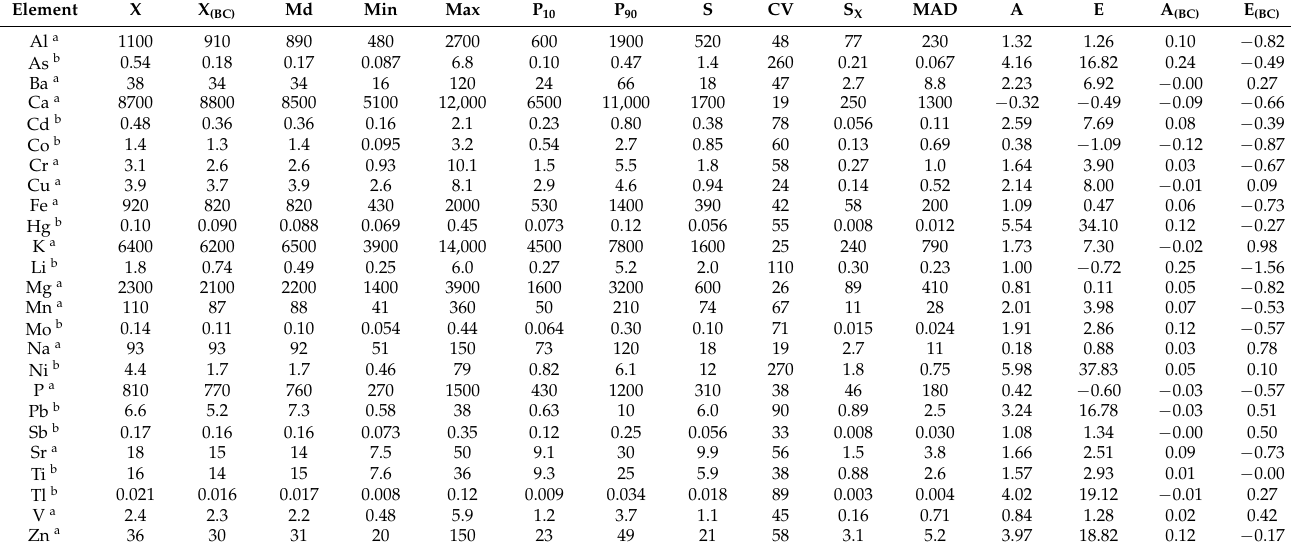
Table 1. Descriptive statistic of measurements for moss samples (in